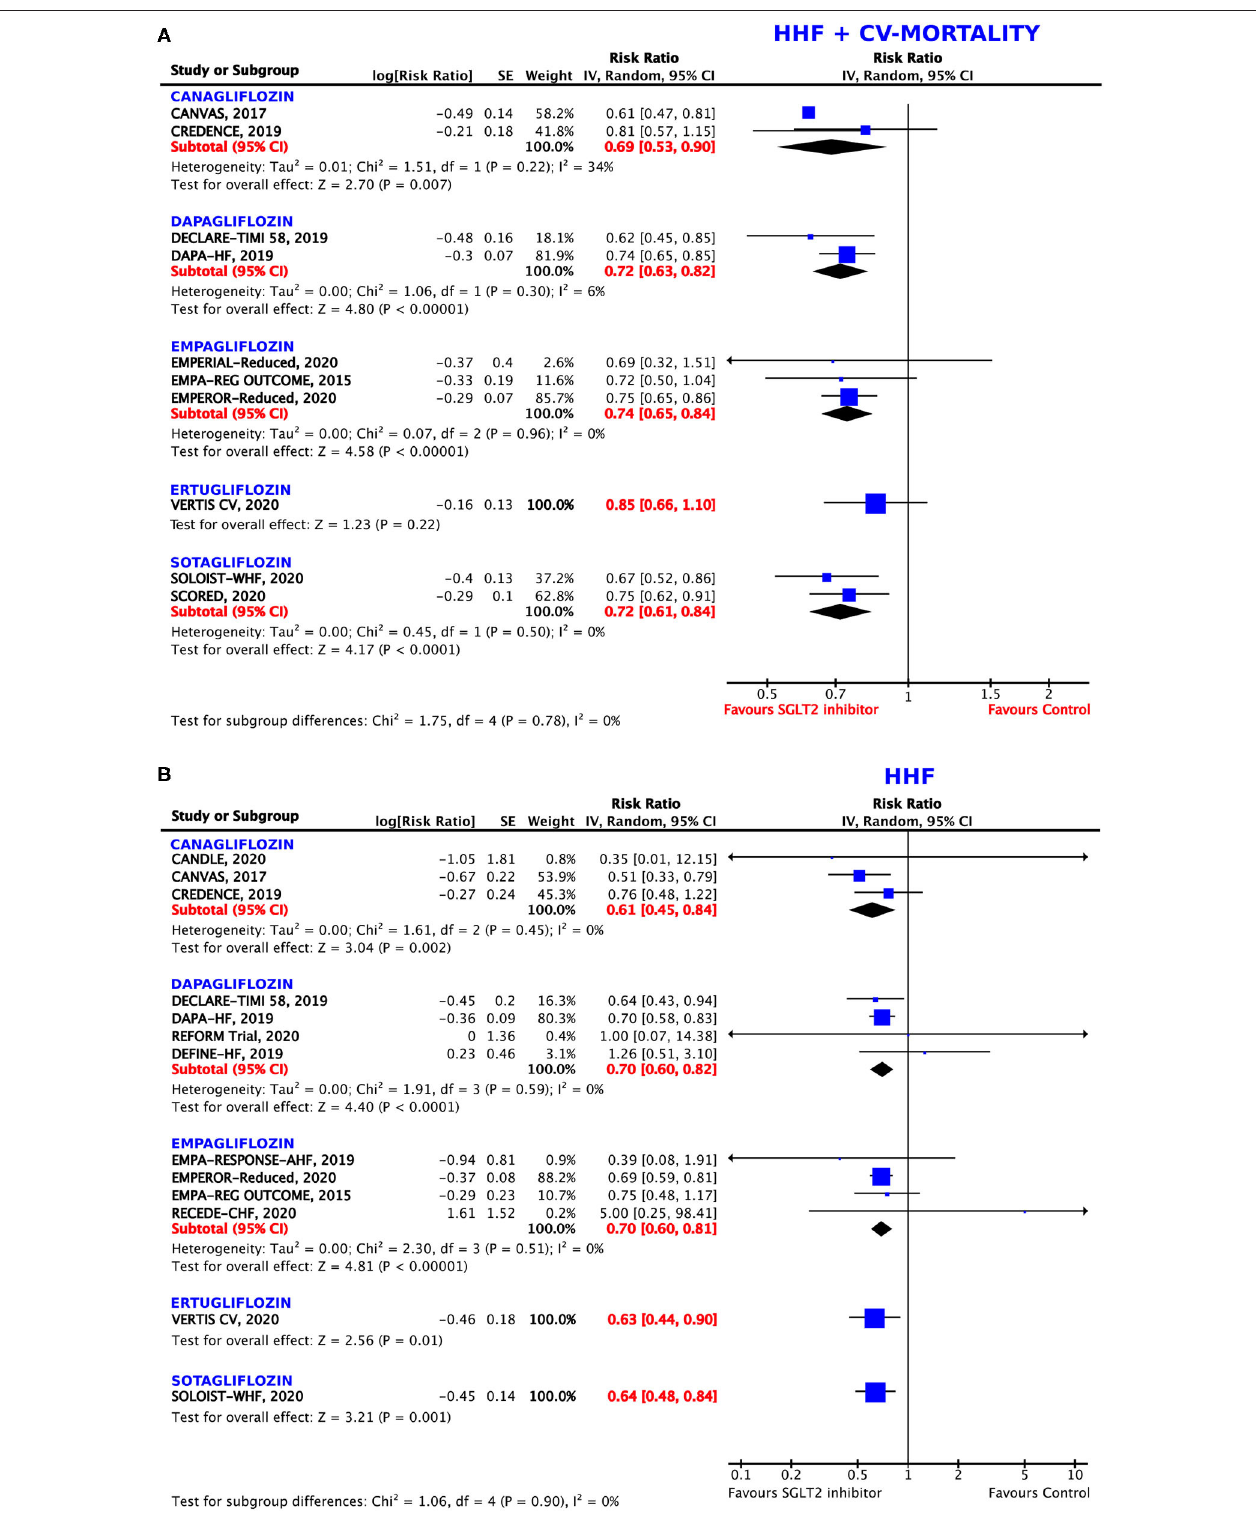
FIGURE 3 | Forest plot depicting the relative risk (RR) according to the administered type of sodium–glucose co-transporter 2 (SGLT2) inhibitor for (A) the composite outcome of hospitalization for heart failure (HHF) or cardiovascular (CV) mortality and (B) HHF alone.